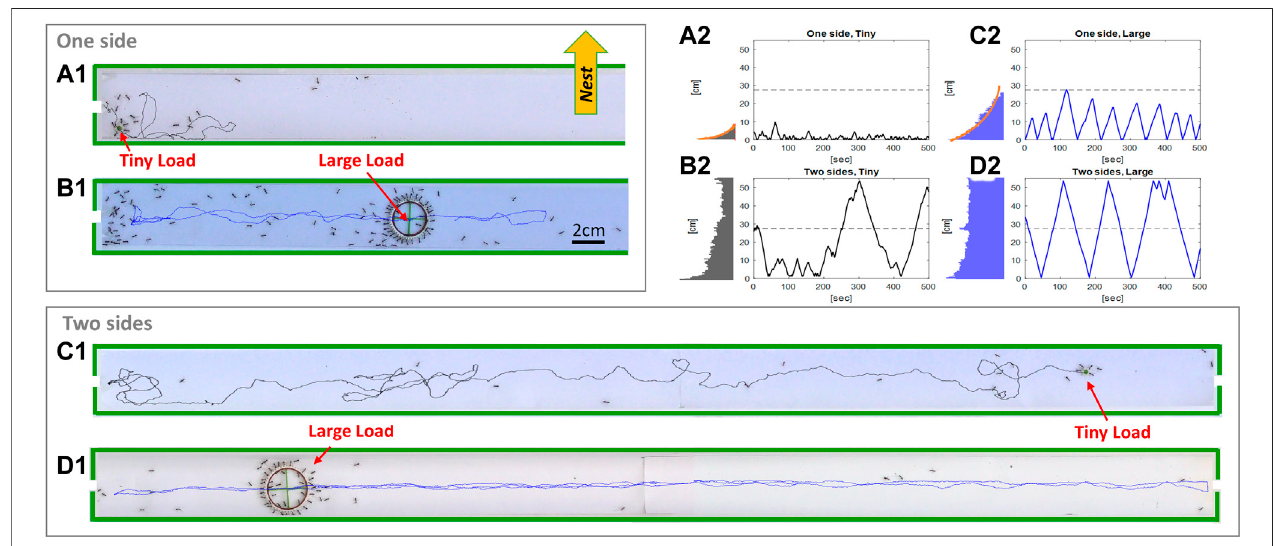
FIGURE 1 | Experimental arena and sample trajectories. (A1 – D1) . Sample snapshots of the left half of a one exit experimental setup (A1,B1) and the two exit experimentalsetup (C1,D1) ,withloadsofradii1.1[cm] (B1,D1) and0.1[cm] (A1,C1) .Fulllinesindicaterecentloadtrajectories.Thedirectiontothenestisforallpanelsis indicatedbytheyellowarrow). (A2 – D2) .Sampletimelinesofloadspositionalongthemainchannelaxis.Numberingasabove.Ahistogramofloadspositionisplottedto the left of each time line. Exponential fi ts (orange) are provided for the single-exit experiments.